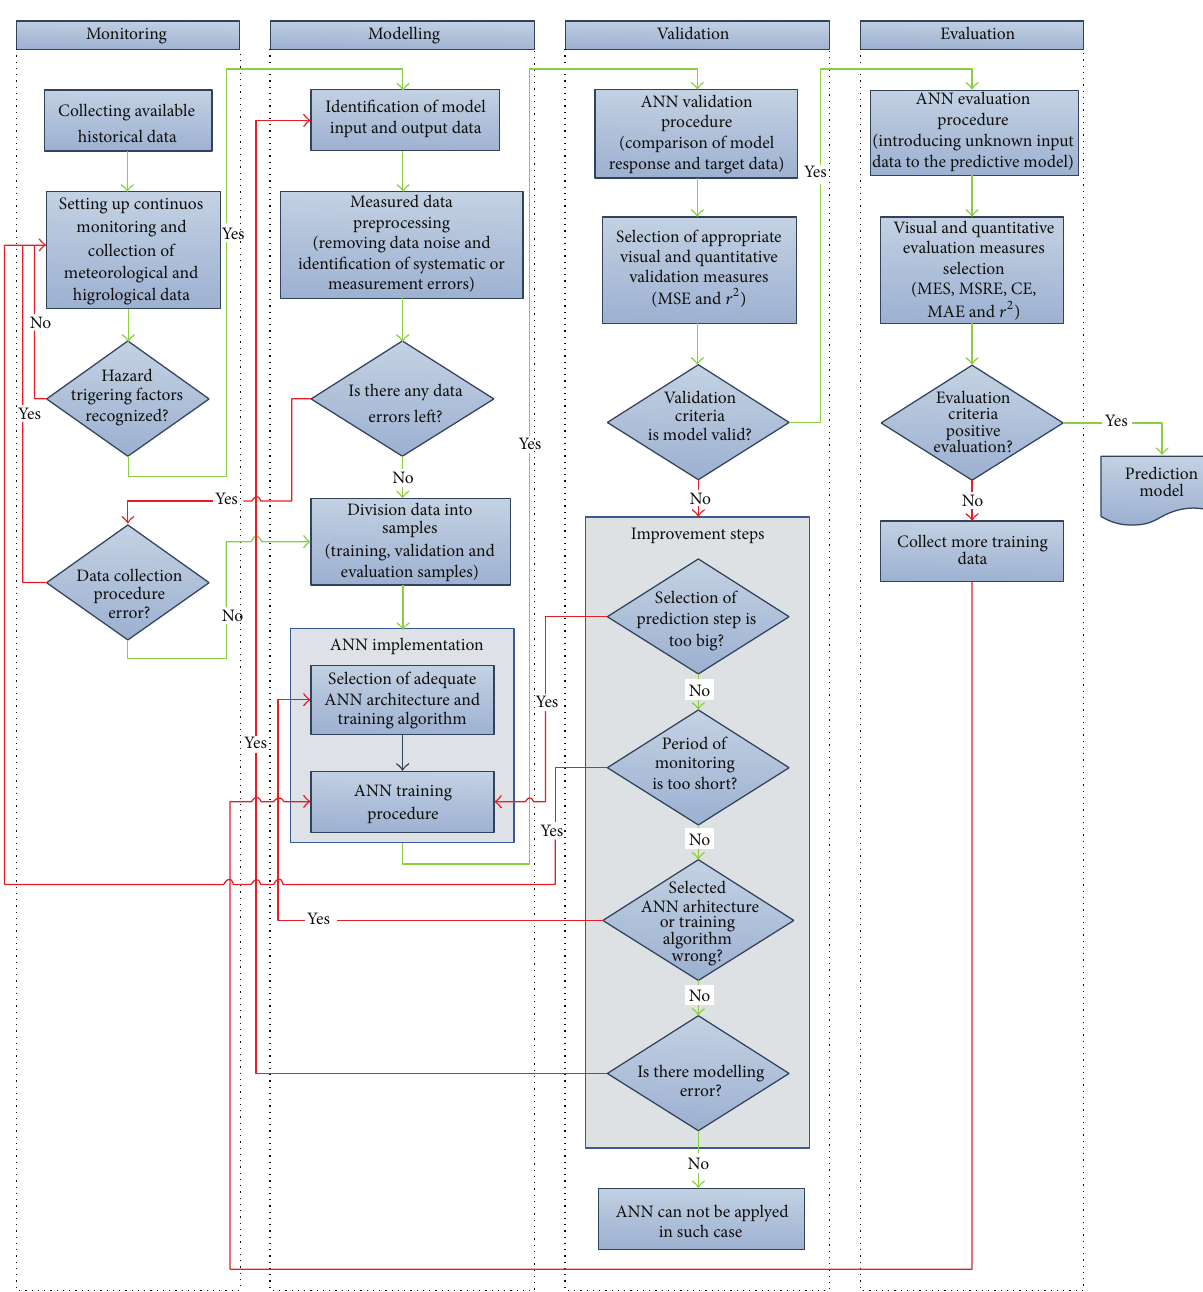
Figure 1: ANN predictive model development flowchart for the small catchments (green direction: forward movement in procedure; red direction: backward movement in